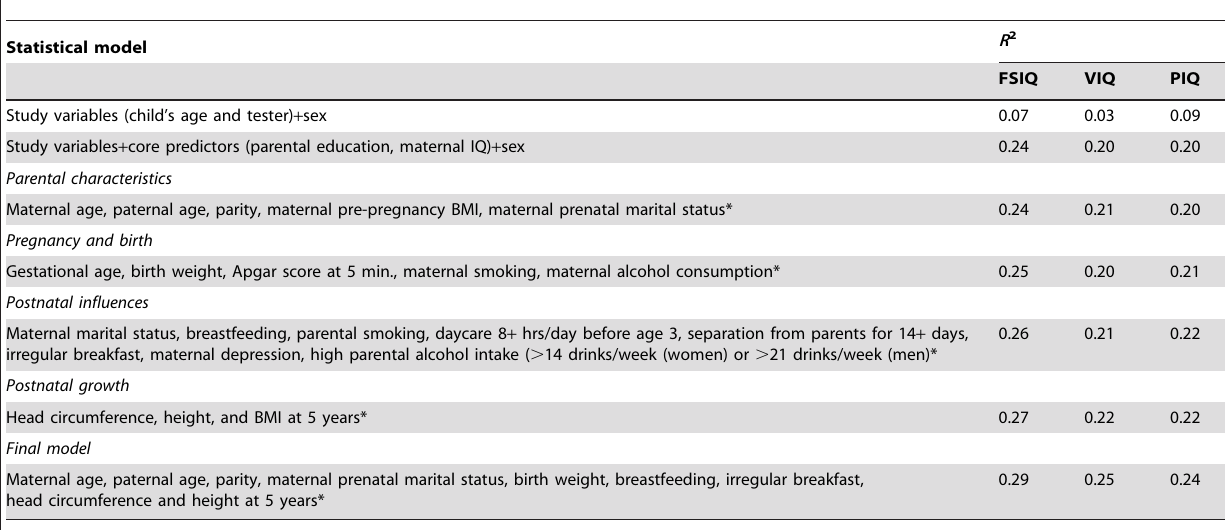
Table 4. Variance explained ( R 2 ) by models of